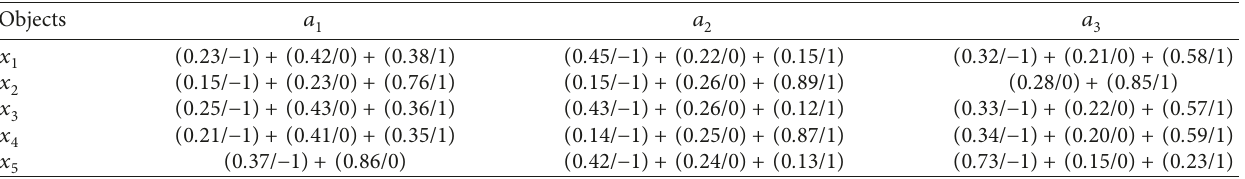
Table 1: A fuzzy set-valued information